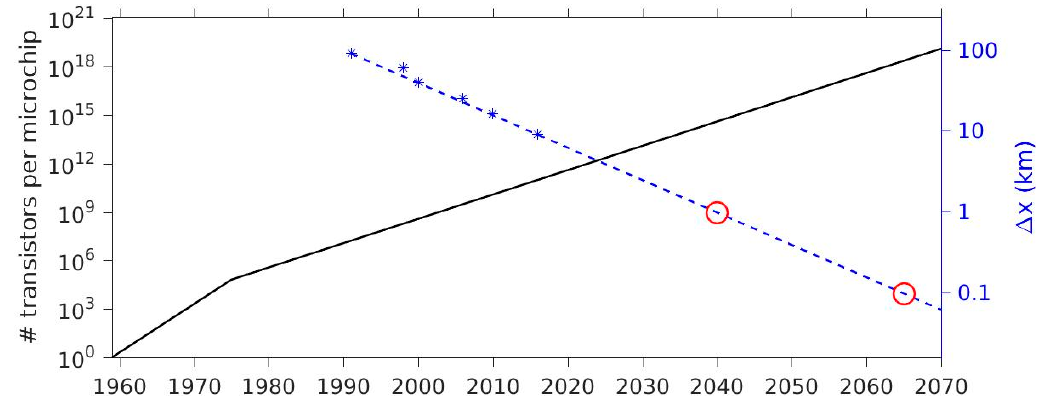
Figure 6. Number of transistors per microchip predicted by Moore’s Law [139] (solid line, left scale) and horizontal grid spacing of the ECMWF IFS (asterisks, right scale). The dashed blue line is a fit that assumes dividing the grid spacing by two every 7.5 years and the red circles indicate the years when a grid spacing of 1 km and 100 m will be reached based on this fit.